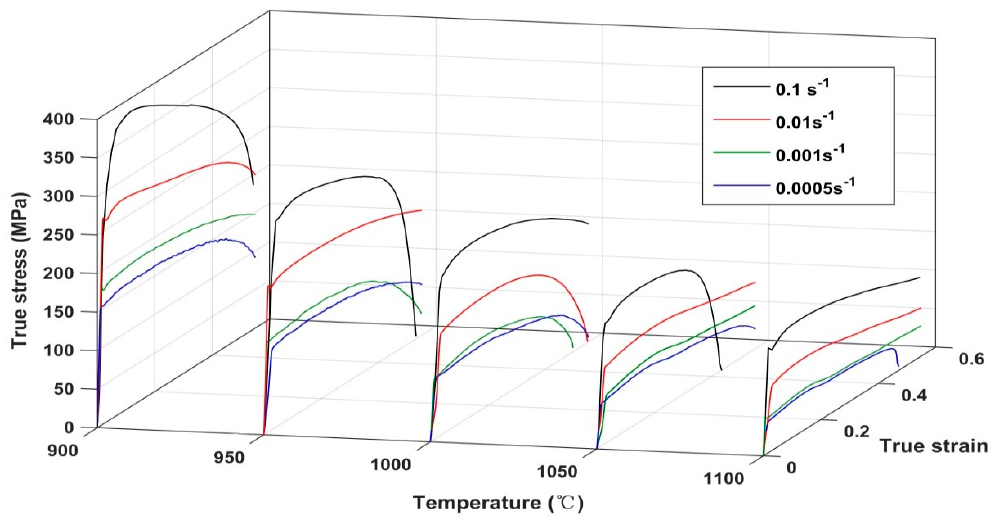
Figure 2. The true stress–strain curve of Inconel 718 at different temperatures and strain rates.